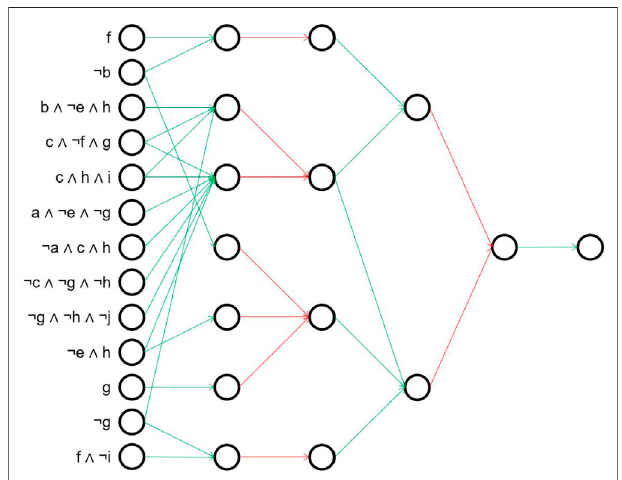
FIGURE 8 | Simpli fi ed model of DRNC(5) for arti fi cial dataset with seed 44.Forabetteroverview,the fi rstlayerishiddenandinsteadtheresultingrules arelisteddirectly.RedconnectionsarelogicalANDs,greenedgescorrespond to logical ORs.